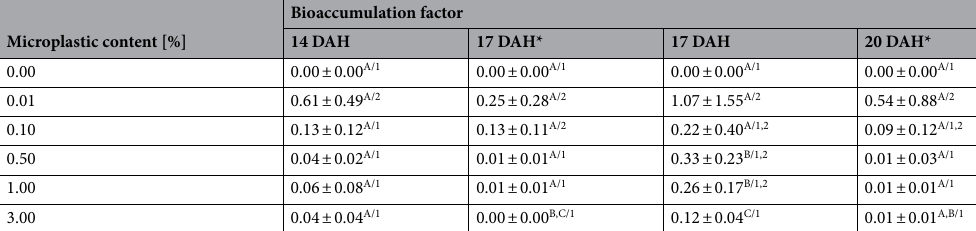
Table 1. Bioaccumulation factors ( BAF ) of black soldier fly larvae reared on an artificial food waste stream containing different microplastic contents. *After three days of starvation. The letters (A,B,C) depict a significant difference between different columns within the same row, while the numbers (1,2) represent a significant difference between different rows within the same column. The results shown are the mean values ( n = 9), together with their standard deviations.